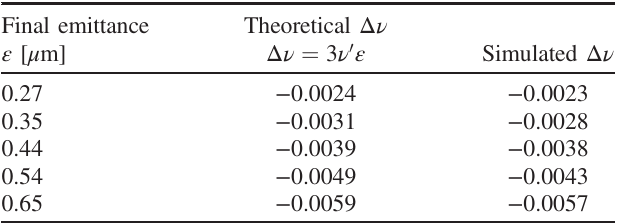
TABLE III. Example of using the echo spectrum to measure the detuning, using a small amplitude dipole kick. All the echoes were generated with the same dipole kick of 1 mm and the same quadrupole kick q ¼ 0 . 01 . The final unnormalized emittance is shown in the first column. In all cases, the emittance increased by Δ ε ¼ 0 . 05 μ m. The second and third columns show the theoretical and simulated tune shifts respectively. The value of ν 0 ¼ − 3009 /m was found using the simulation shown in the left plot of Fig. 10.